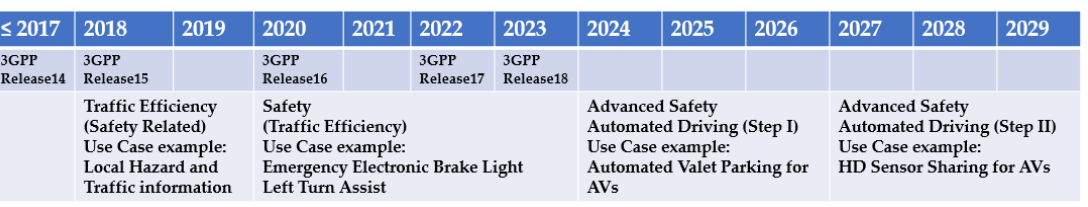
Figure 5. Timeline from the initial introduction to the mass market deployment of C-V2X Use cases